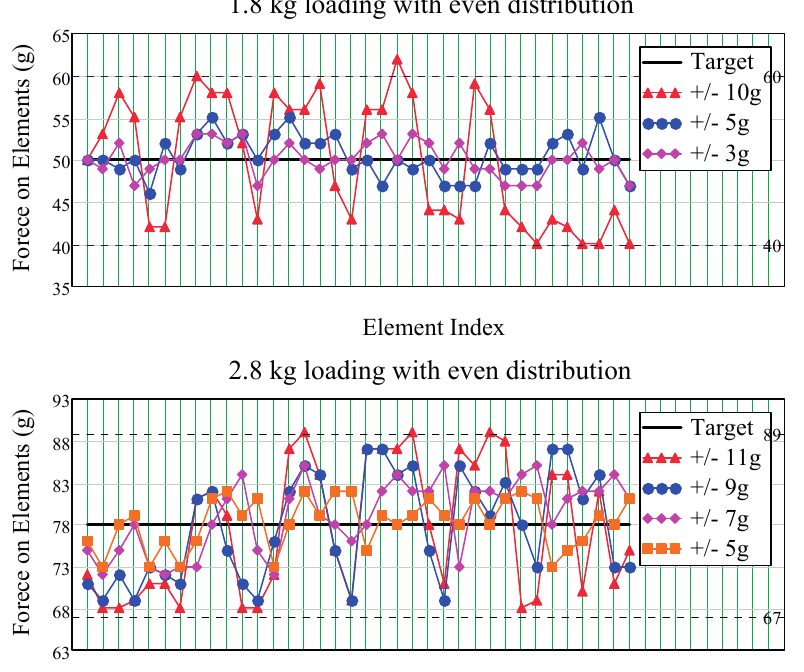
Figure 10. The results of automatic pressure distribution test with even distribution (the dash-lines indicate the upper and lower tolerance